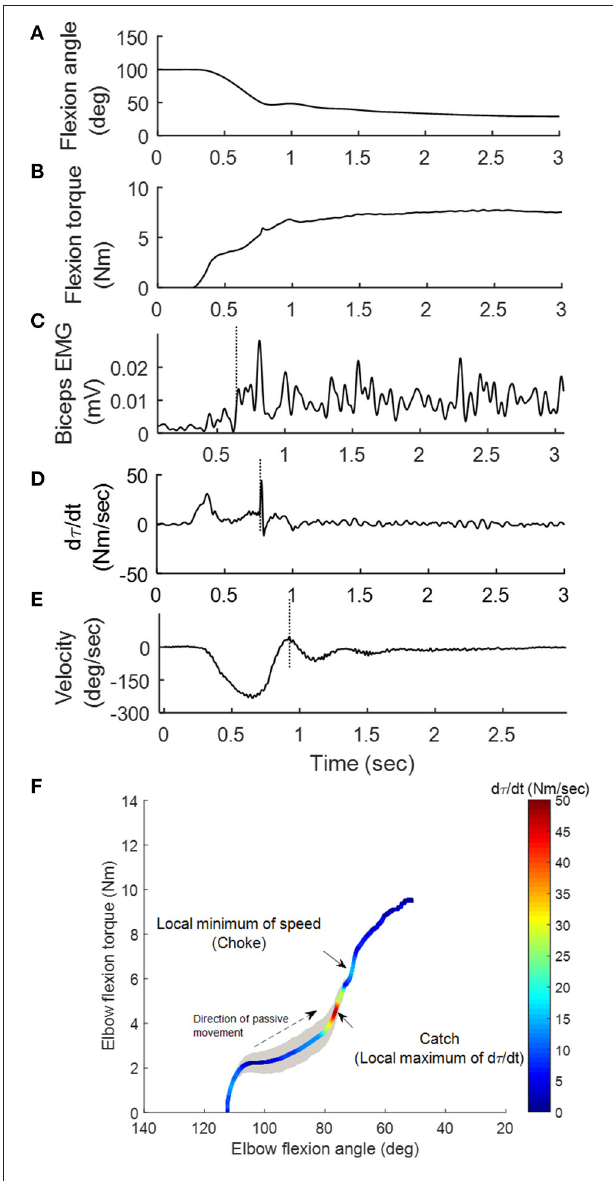
FIGURE 2 | Representative kinematic, kinetic and EMG signals during the passive stretch. As the elbow was moved from 100 ◦ flexion to extension (A) , the elbow flexion torque τ (B) generated by the examiner on the stretched flexor muscles increased accordingly. Sequentially, the stretch induced a reflex response in the biceps (vertical line in C ). The operator felt the sudden increase in resistance (vertical line in D ) during the “catch,” and responded by decreasing the stretch velocity (vertical line in E ). A four-dimensional display ( F ) was developed to illustrate the aforementioned